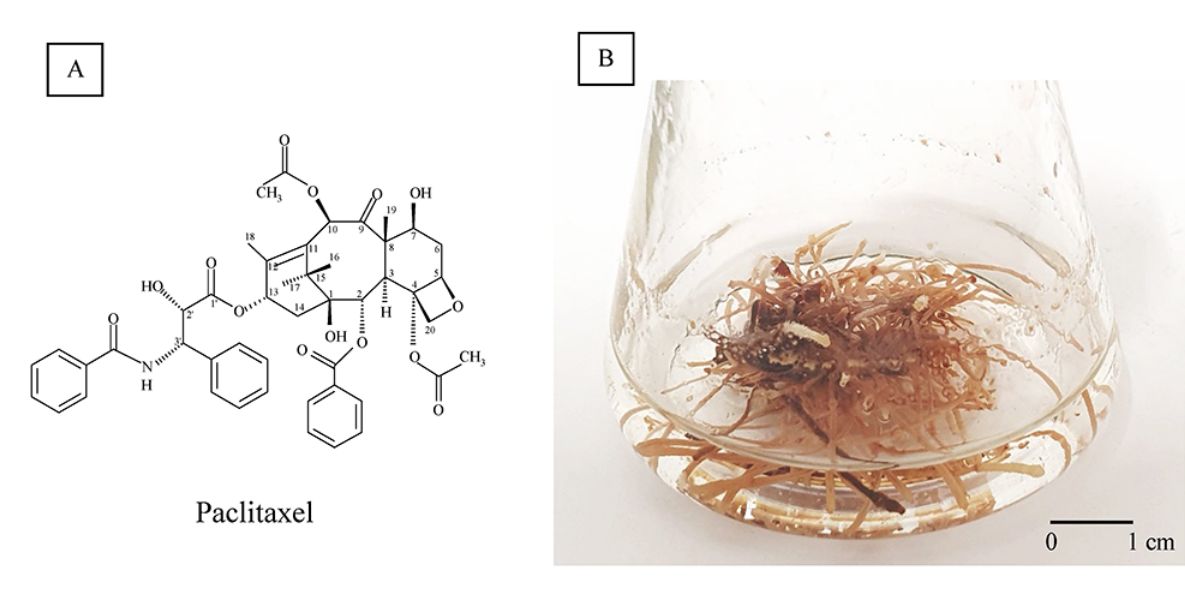
Figure 1 ( A ) Paclitaxel structure. ( B ) Taxus ×media hairy roots obtained aer transformation with Agrobacterium rhizogenes LBA